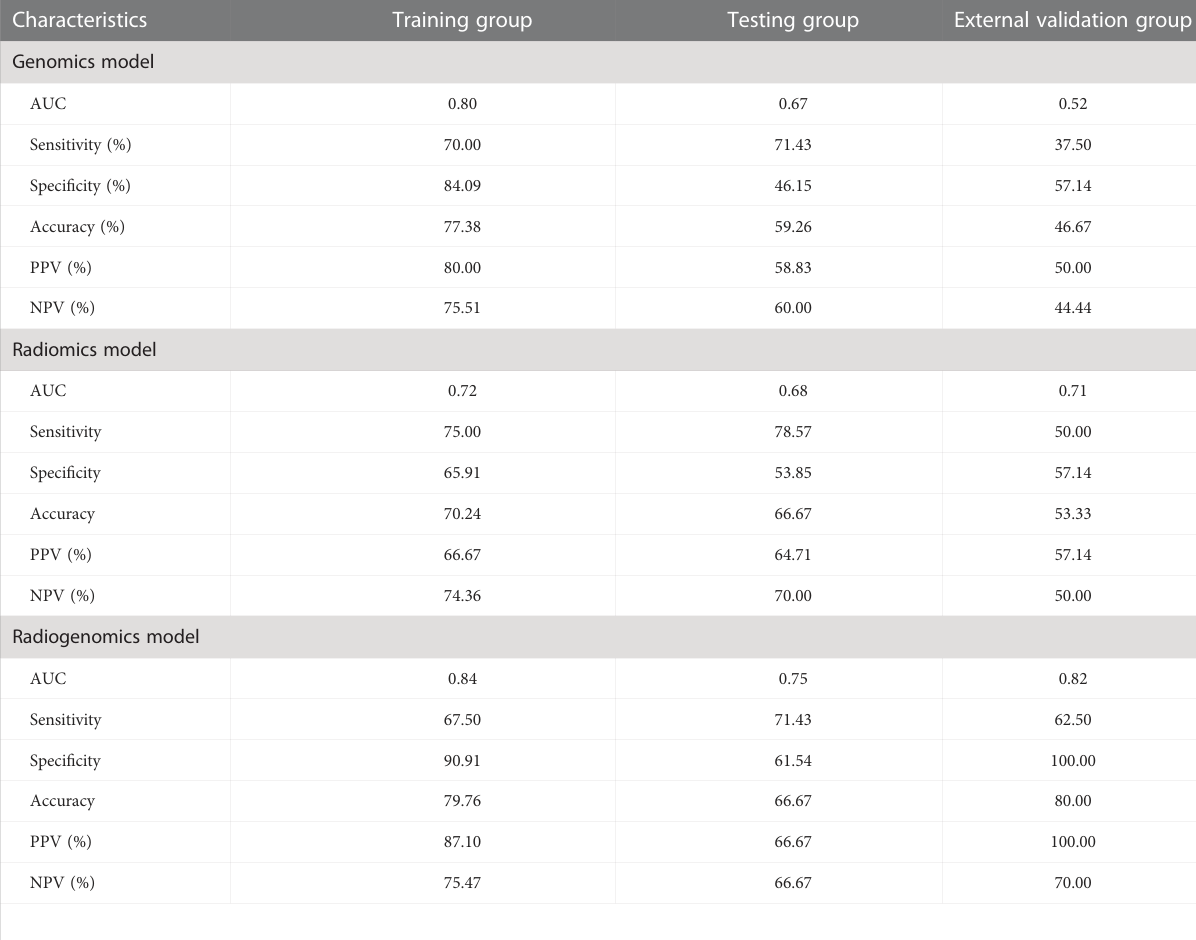
TABLE 2 The performance of three models in the training, testing and external validation